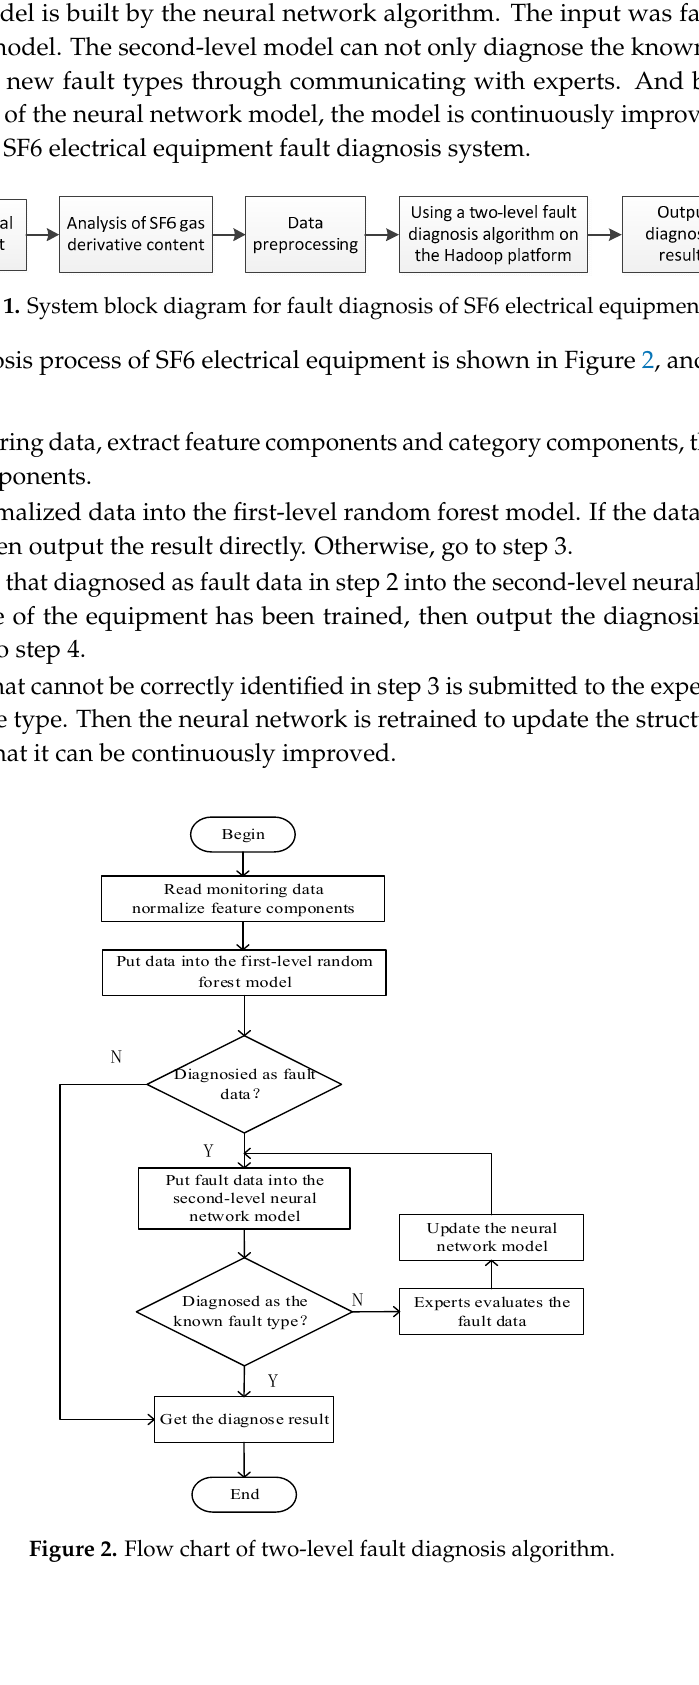
Figure 2. Flow chart of two-level fault diagnosis algorithm.